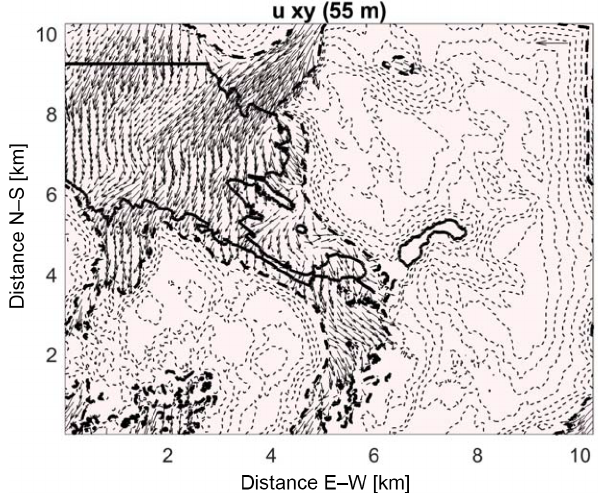
Figure 5. Vertical profiles for temperature and wind speed and wind direction (lower panels) at three locations in the Bergen Valley (marked in the upper panels). The figures show the 15min mean data corresponding to case 3 presented in Fig. 4. All profiles are horizontal averages over the areas indicated in the top panels. The blue areas indicate water surface. The brown shading gives the sur- face elevation in metres. The AMS is located in the centre of area 2. The geostrophic wind profile for this scenario is indicated as a black line in the lower middle panel.